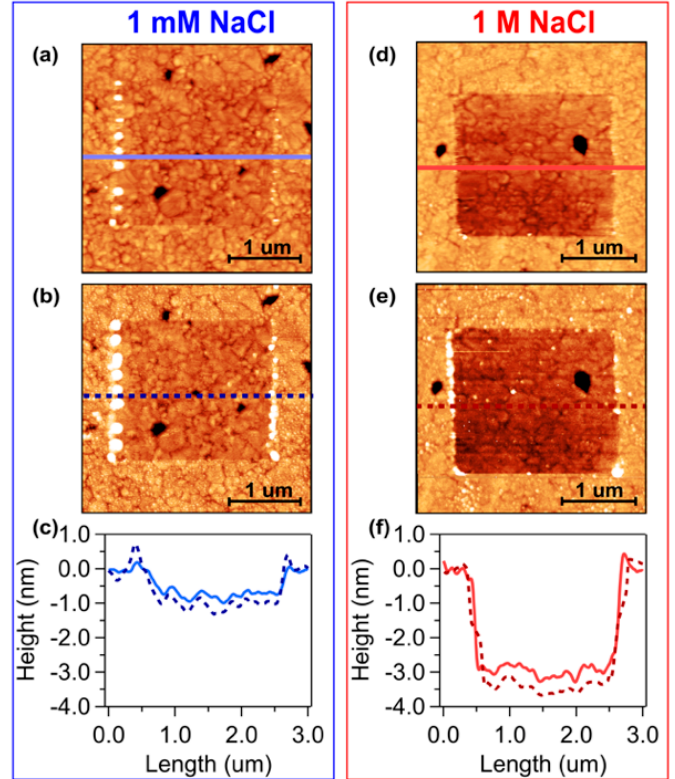
Figure 1. Shaving experiments on C 6 -ssDNA SAMs prepared in ( a–c ) 1 mM NaCl and ( d–f ) 1 M NaCl buffer. Height images of the shaved areas acquired in ( a,d ) contact mode and in ( b,e ) Quantitative Imaging (QI) mode (data scale: 9 nm). ( c,f ) z-profiles relative to contact images (light, continuous lines) and QI images (dark, dashed lines).